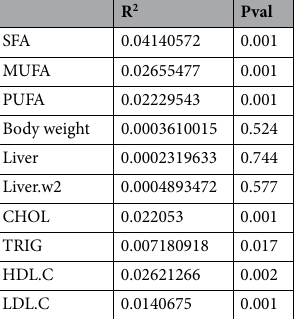
Table 3. Results of the multiple regression on matrices (MRM) analysis for the whole bacterial